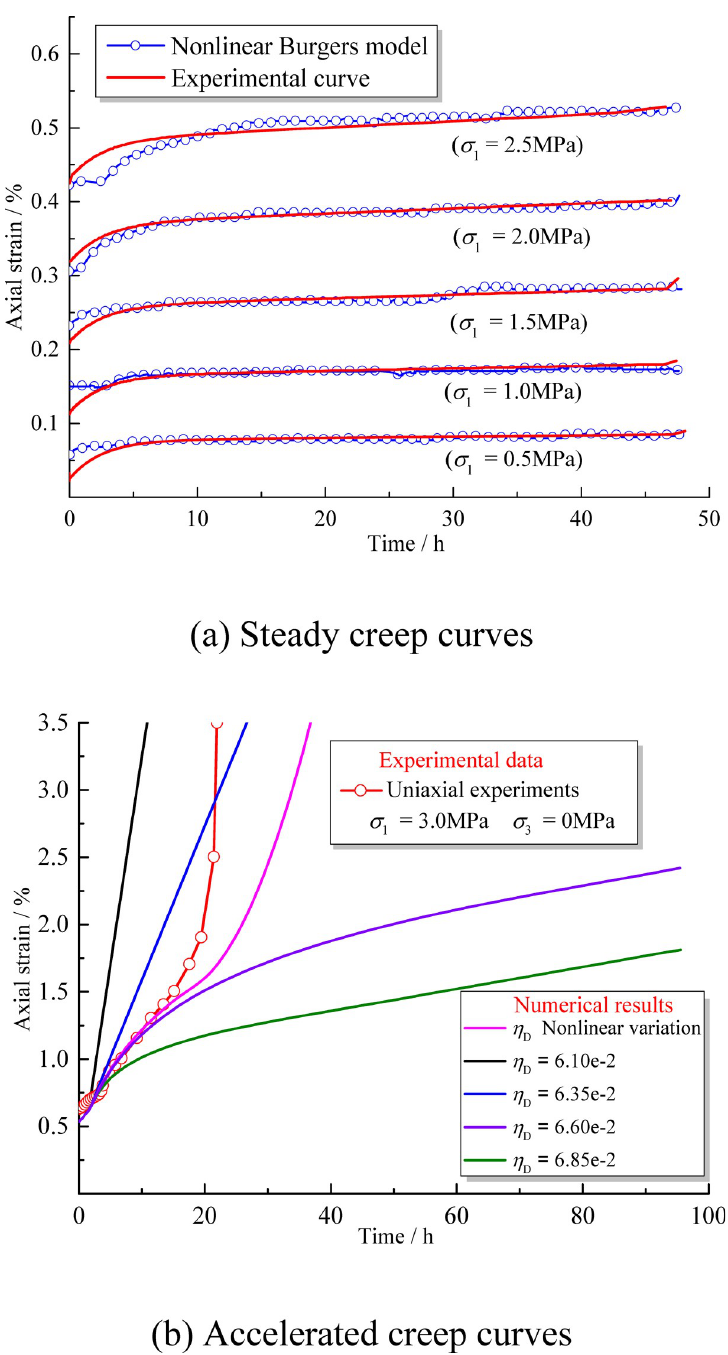
Fig 10. NBSS model curves alongside experimental curves. (a) Steady creep curves (b) Accelerated creep curves. criterion is then used to assess the elastic-plastic state of the numerical element. If the numeri- cal element enters the plastic state, the viscoplastic strain is not converted into plastic shear strain. The stress is updated according to the plastic shear strain increment reaching after the peak value, and c and φ continue to vary with increasing plastic shear strain. In the numerical